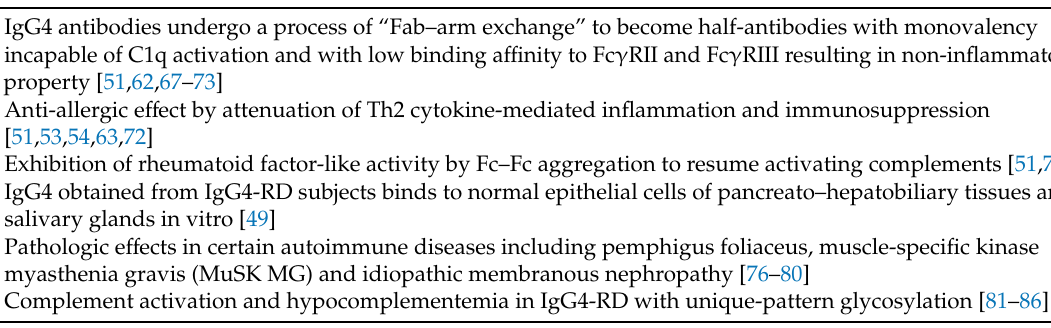
Table 5. Odd immunological properties of IgG4 antibodies in patients with IgG4-RD. IgG4 antibodies undergo a process of “Fab–arm exchange” to become half-antibodies with